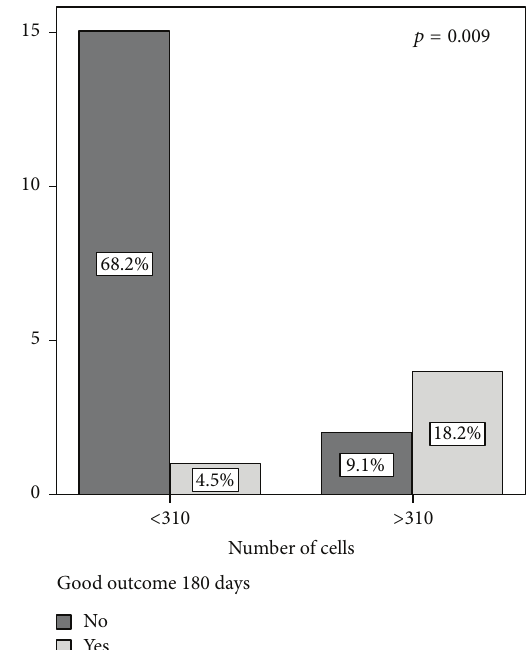
Figure 2: Analysis of a dose cut-off (310 × 10 6 BM-MNCs injected) and outcomes after 180 days. Patients with good outcomes had no or mild disability (mRS of 0–2). Values are expressed in millions of